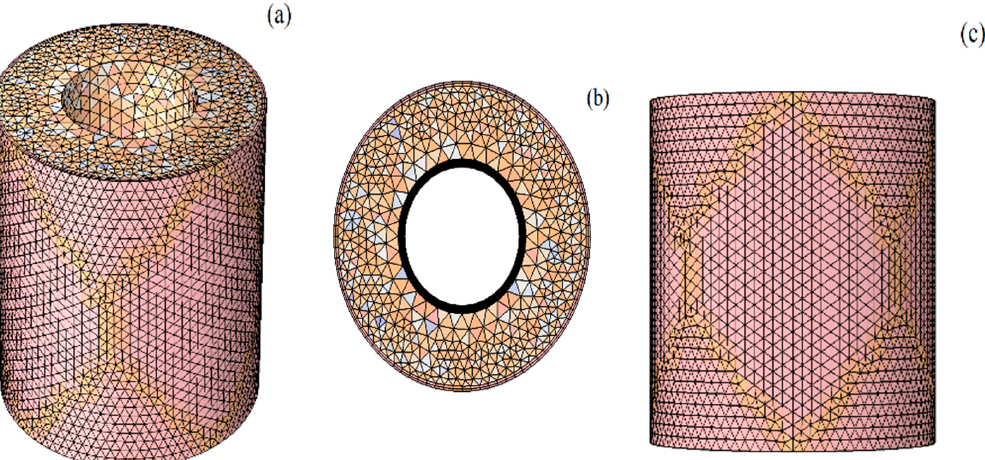
Figure 2. ( a – c ) The meshing process of the three-dimensional annular tube with tetrahedral elements.